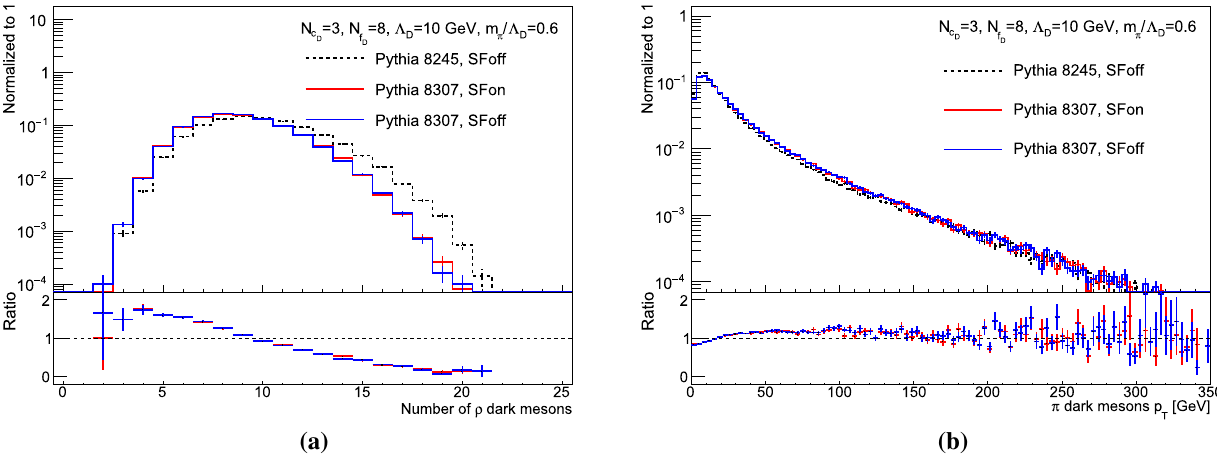
ρ D mesons, b D meson p T distribution. The bottom panels show the ratio of